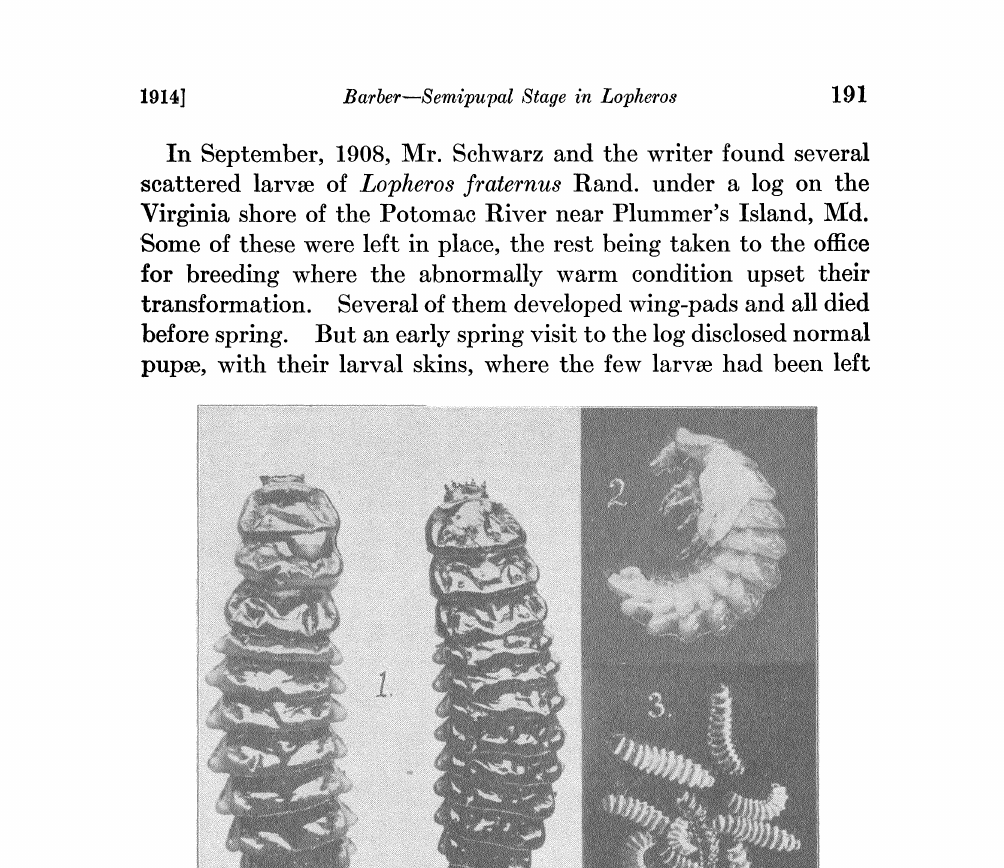
Fig. 1. Lopherus fraternus